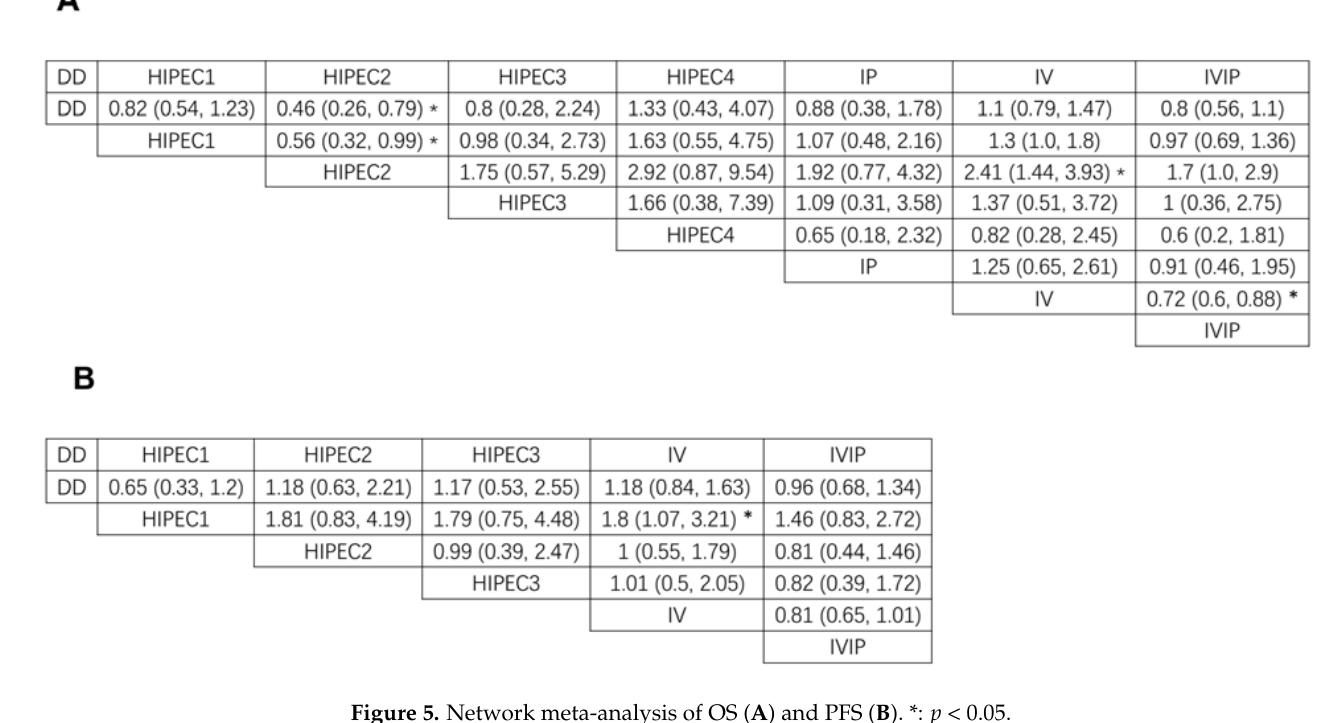
Figure 5. Network meta-analysis of OS ( A ) and PFS ( B ). *: p < 0.05. According to SUCRA, HIPEC2 (76.17%) had the highest probability in improving OS, followed by acupoint catgut embedding (30.8%), and HRT (25.3%).